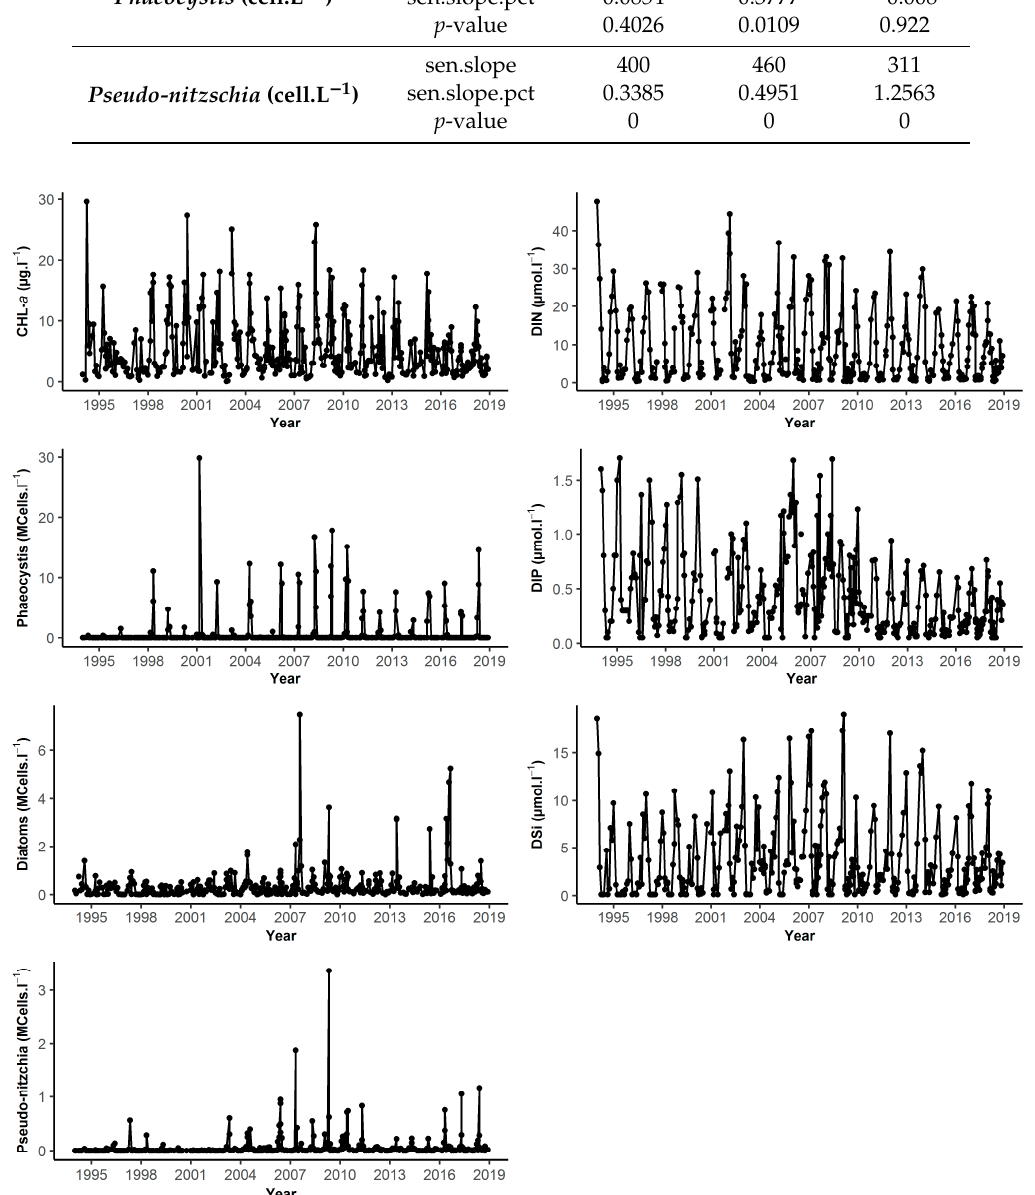
Figure 3. Annual time series of available parameters in the coastal station of Boulogne (BL1) for the period 1994–2018 (raw data).